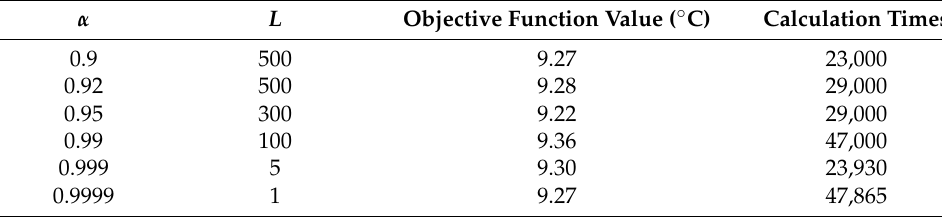
Table 4. Optimization results under different α and L .